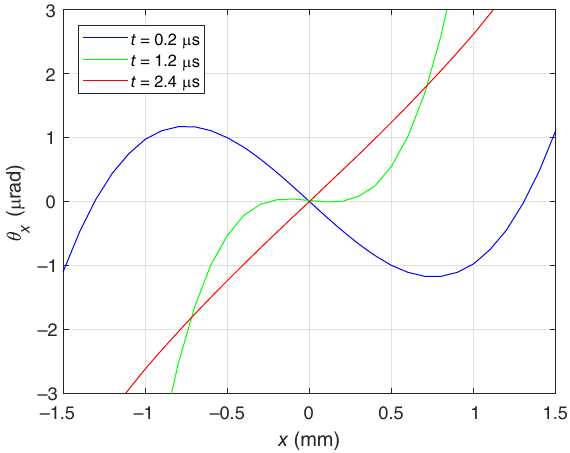
FIG. 9. Variations of θ x with respect to the horizontal position, under 10 kV at three different times of the pulse. The extrema of the quadrupolar strength are reached during the current rise, at t ¼ 0 . 2 μ s (blue), and the current fall, at t ¼ 2 . 4 μ s (red), while the field exhibits its nominal octupolar shape at peak current, t ¼ 1 . 2 μ s